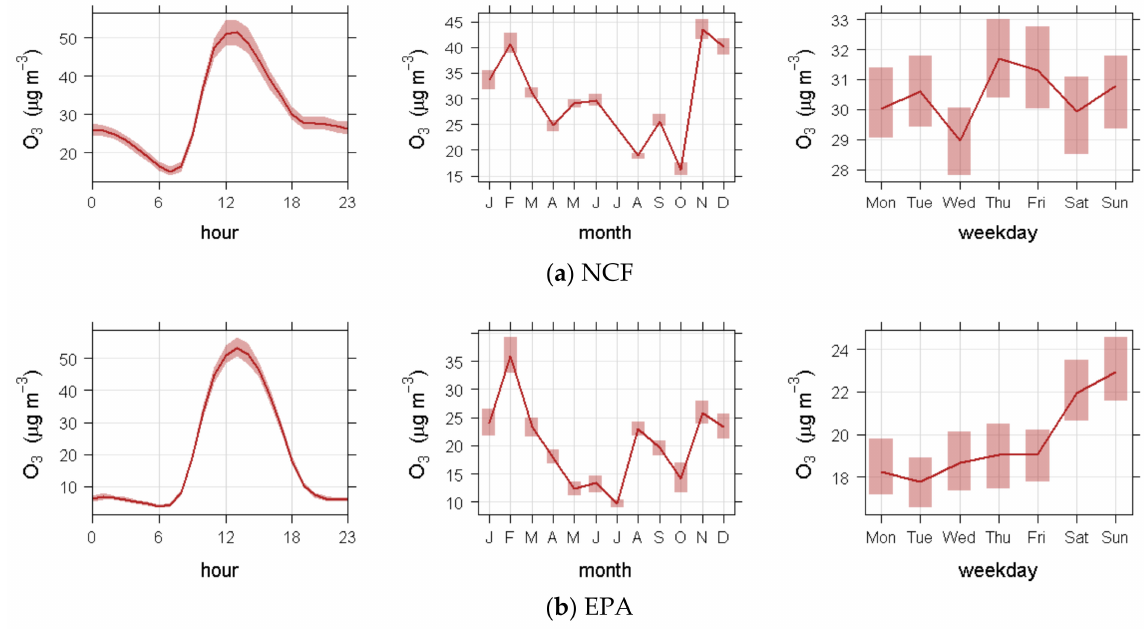
Figure 6. Annual average diel O 3 concentrations for sites NCF ( a ) and EPA ( b ). Ozone concentrations for the other sites are in Figures